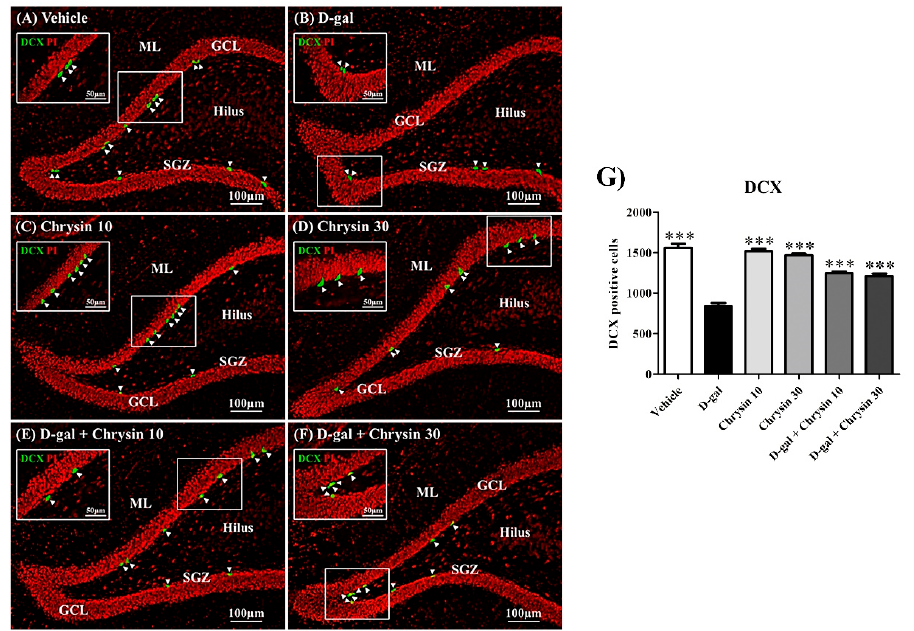
Figure 7. Doublecortin (DCX) immunofluorescence staining of all groups ( A – F ). DCX positive cells (green) are indicated by arrowheads, and all nuclei were counterstained with propidium iodide (red). The vehicle, chrysin 10, chrysin 30, and D-gal + chrysin groups had significantly greater numbers of DCX-positive cells than the D-gal group (*** p < 0.001, ( G )). SGZ: subgranular zone; GCL: granule cell layer; ML: molecular layer.